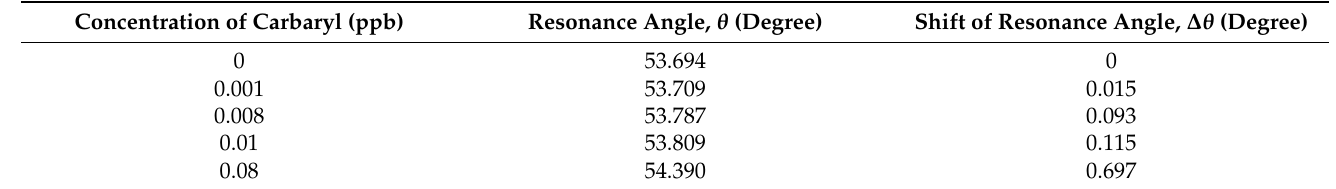
Table 2. The resonance angle and shift of resonance angle for the detection of various concentrations of carbaryl (0 − 0.08 ppb).